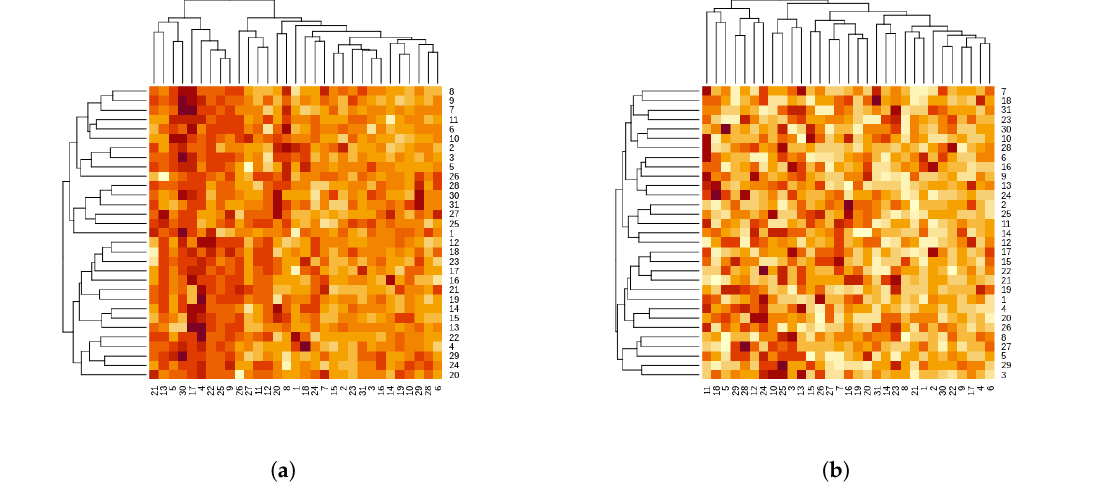
Figure 4. Example of heatmaps from a bi-dimensional magnetic field signature. The numbers presented in labels x and y represent the fingerprints, showing the structure of the relationship between